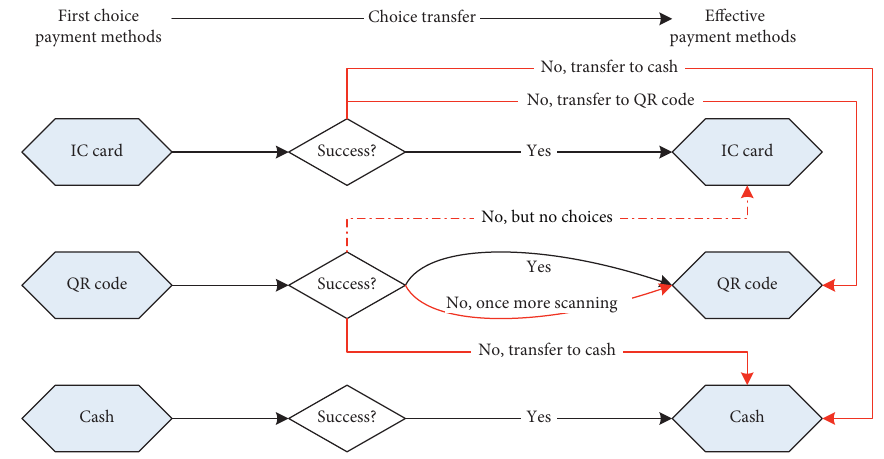
Figure 4: The choice transfer among different payment